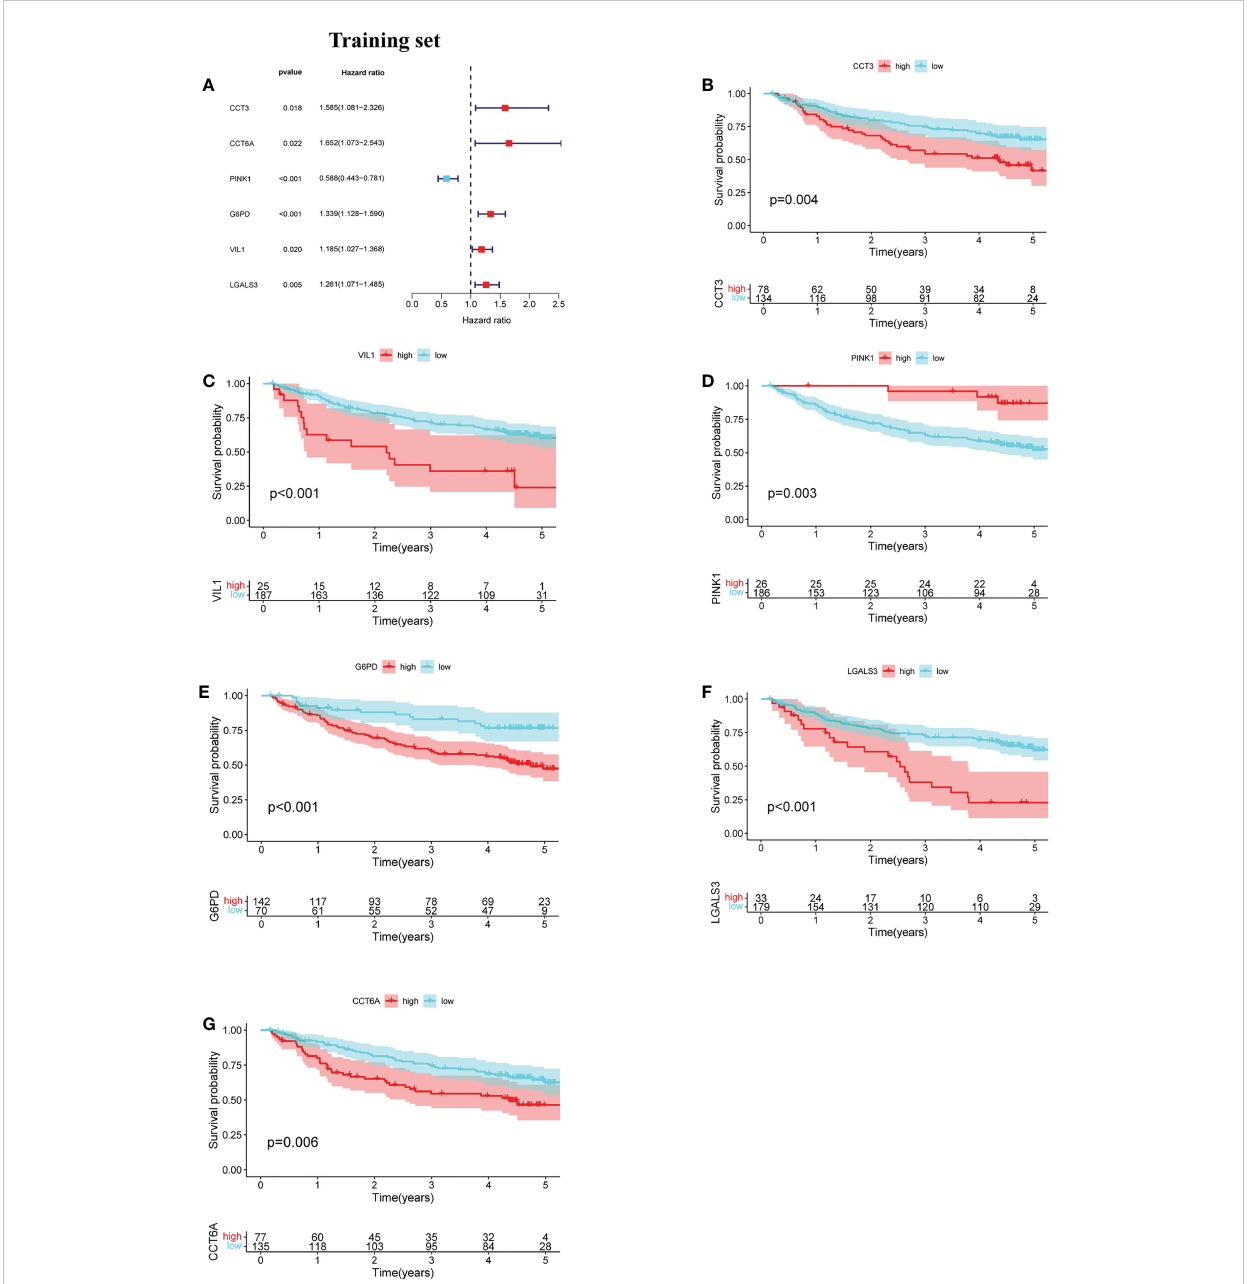
FIGURE 3 Development of the NRGPS System. (A) The forest map of 6 prognostic genes were obtained by Univariable Cox regression analysis. (B – G) Kaplan- Meier curve of 6 prognostic